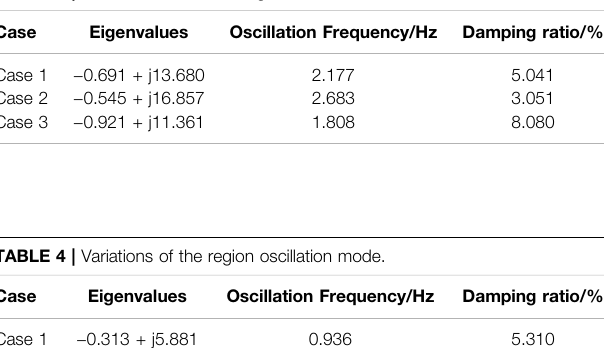
TABLE 3 | Variations of the shafting oscillation mode.